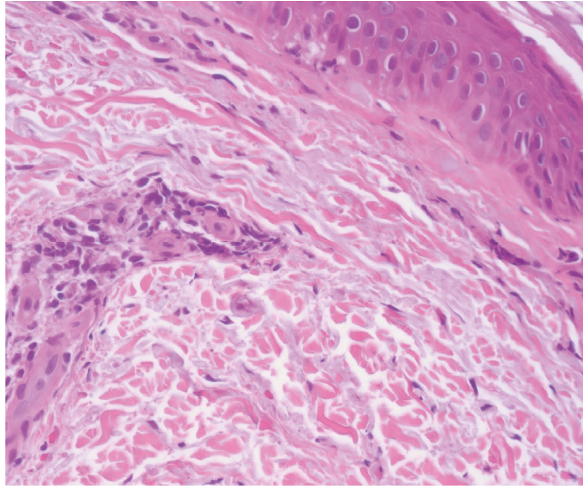
Figure 4: H&E (40x) shows early fibrinoid changes and scattered neutrophils consistent with leukocytoclastic